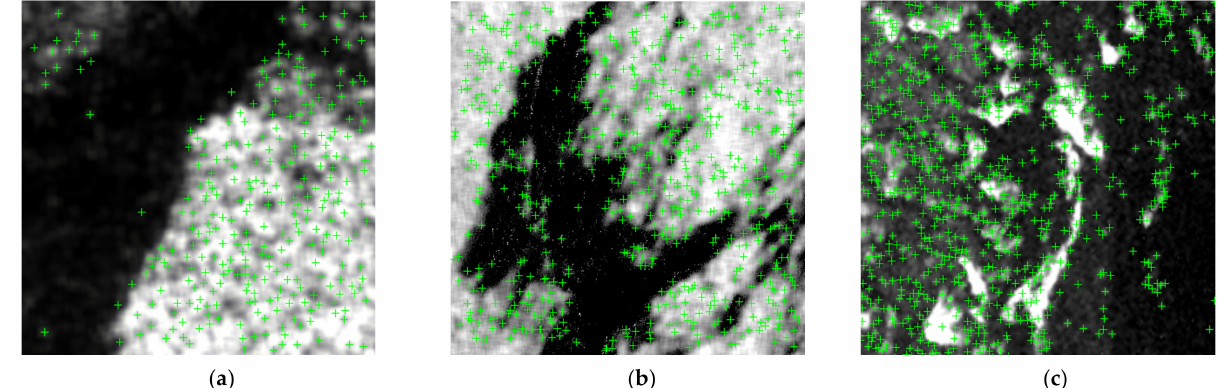
Figure 1. Results of sea ice, oil spill, and enteromorpha SAR image feature extraction using the sift algorithm. ( a ) Sea ice SAR data are Radarsat-2 data from Mackenzie Trough on 4 April 2010. ( b ) Oil spill data are Radarsat-2 data from the Gulf of Mexico as of 8 May 2010. ( c ) Enteromorpha data are Sentienl-1 data from Yellow Sea in China on 6 June